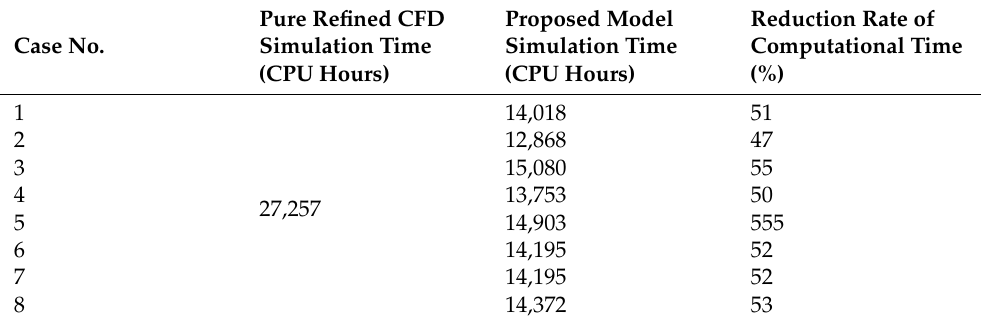
Table 10. Comparison of the computational time for pure refined CFD and the proposed model (4 training data